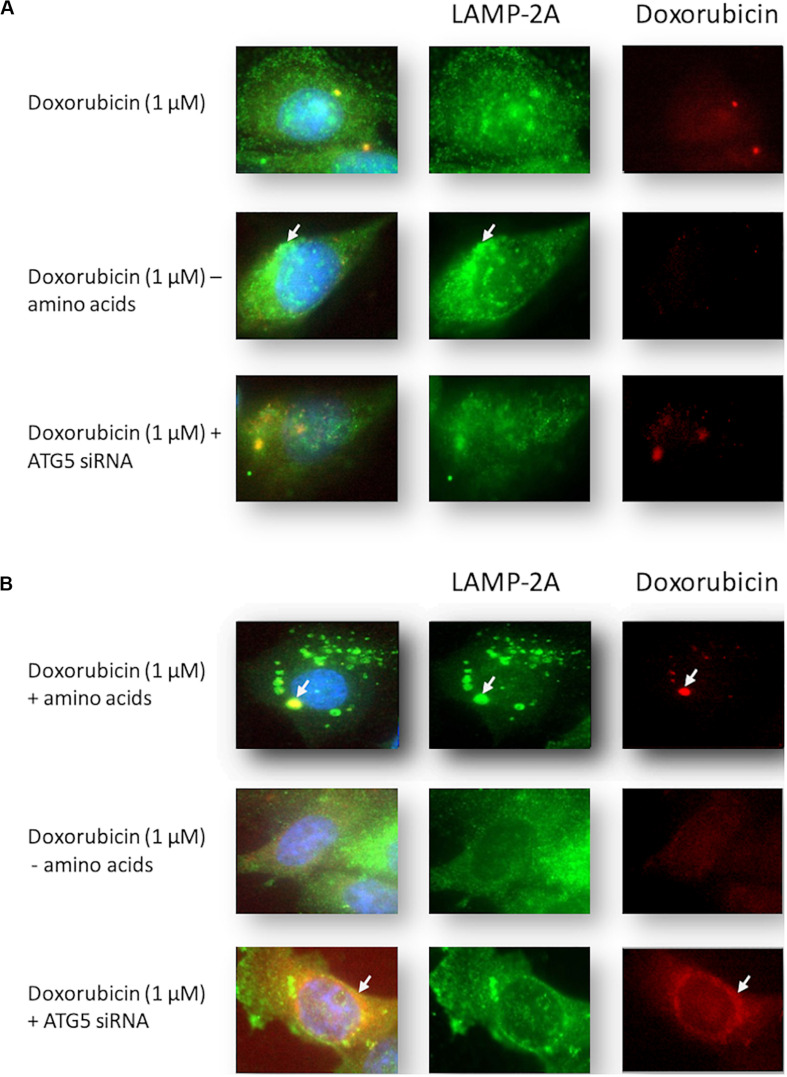
Intracellular localization of LAMP-2A and Dox in Dox-treated MCF12A and MDAMB231 cells following amino acid starvation and autophagy inhibition. Representative images of LAMP-2A (green) straining and Dox (red) in MCF12A (A) and MDAMB231 (B) cells treated with Dox in culture medium without amino acids or with ATG5 siRNA. Arrows highlight differences in localized signals of LAMP-2A and Dox. Comparative control groups (cells treated with Dox in the presence of amino acids) are shared between Figure 4 and Figure 7 since treatment groups from both figures were performed together in one experiment. Images were obtained using a 40× objective.